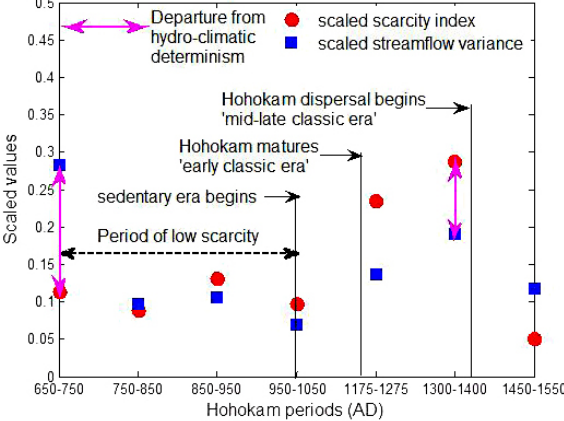
Fig. 15. Changes of “apparent” stochasticity of runoff availability over various periods in the Hohokam area. The stream flow vari- ance and the scarcity index (“apparent” stochasticity) are scaled be- tween 0 and 1 by dividing the values by its sum over the considered